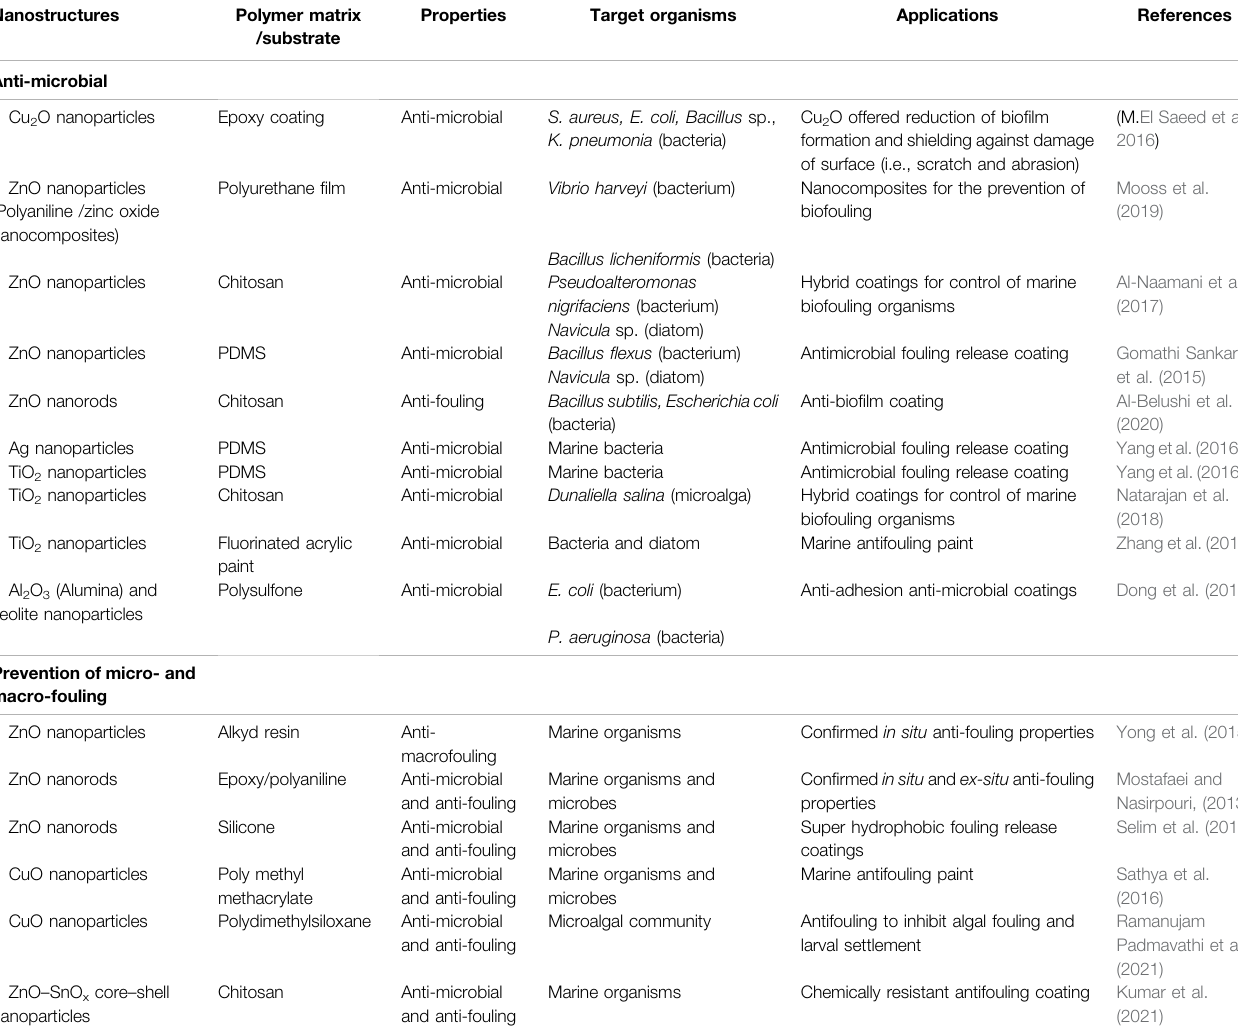
TABLE 2 | Metal oxide nanocomposite coatings for marine antifouling